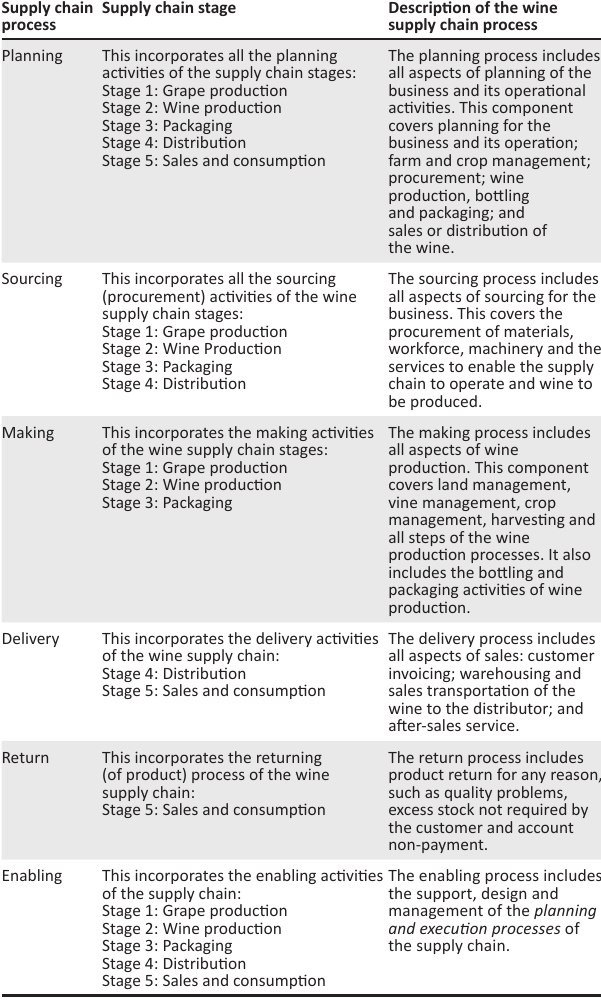
TABLE 2: Activities in the South African wine supply chain.